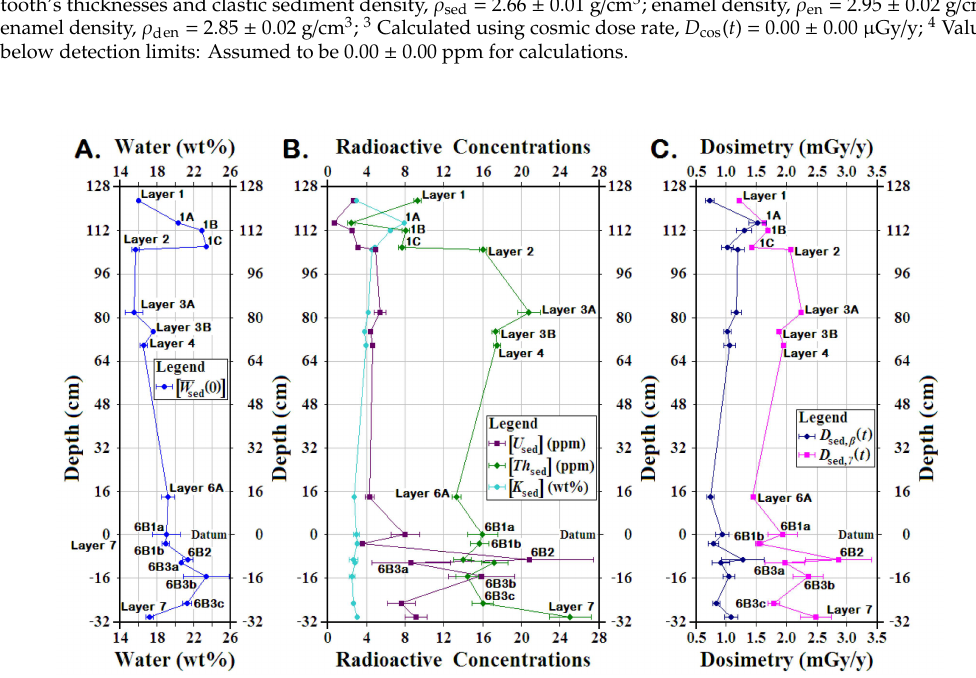
Figure 6. Factors a ff ecting sedimentary dosimetry vs. depth, Saradj-Chuko Grotto (SCG),